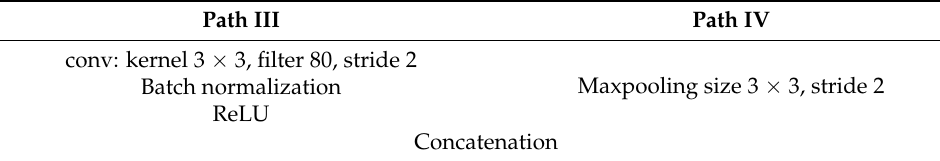
Table 6. Downsampling module1